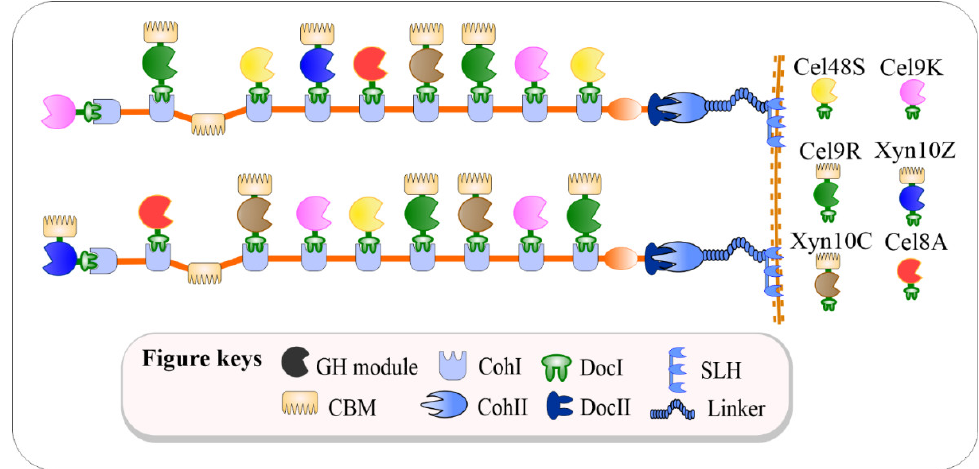
Figure 9. Two cell-surface displayed artificial cellulosomes anchored on B. subtilis cells. The upper operon represents the order of enzyme-encoding genes where the CBH and EG genes were placed near the Pr promoter. The lower operon displays enzyme-encoding genes where the Xyn genes were positioned near the Pr promoter.